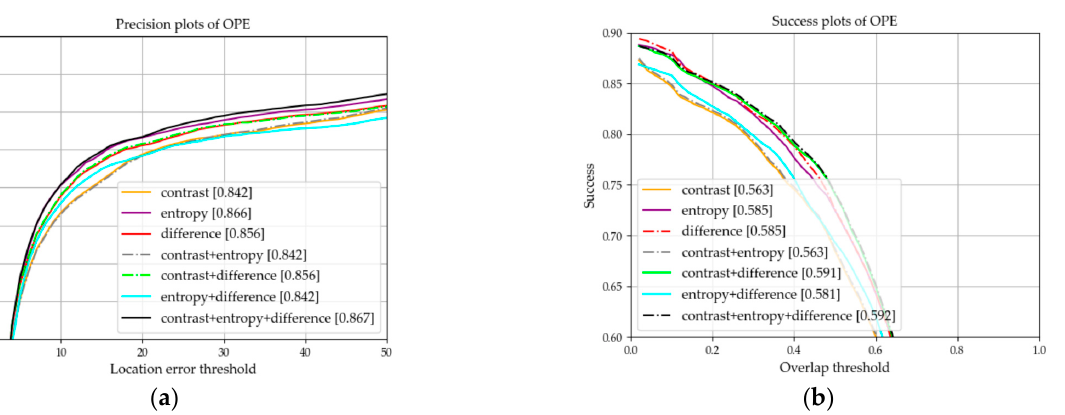
Table 1. Tracking performance comparison of channel selection strategies. The best two results are marked with red and blue. Strategy